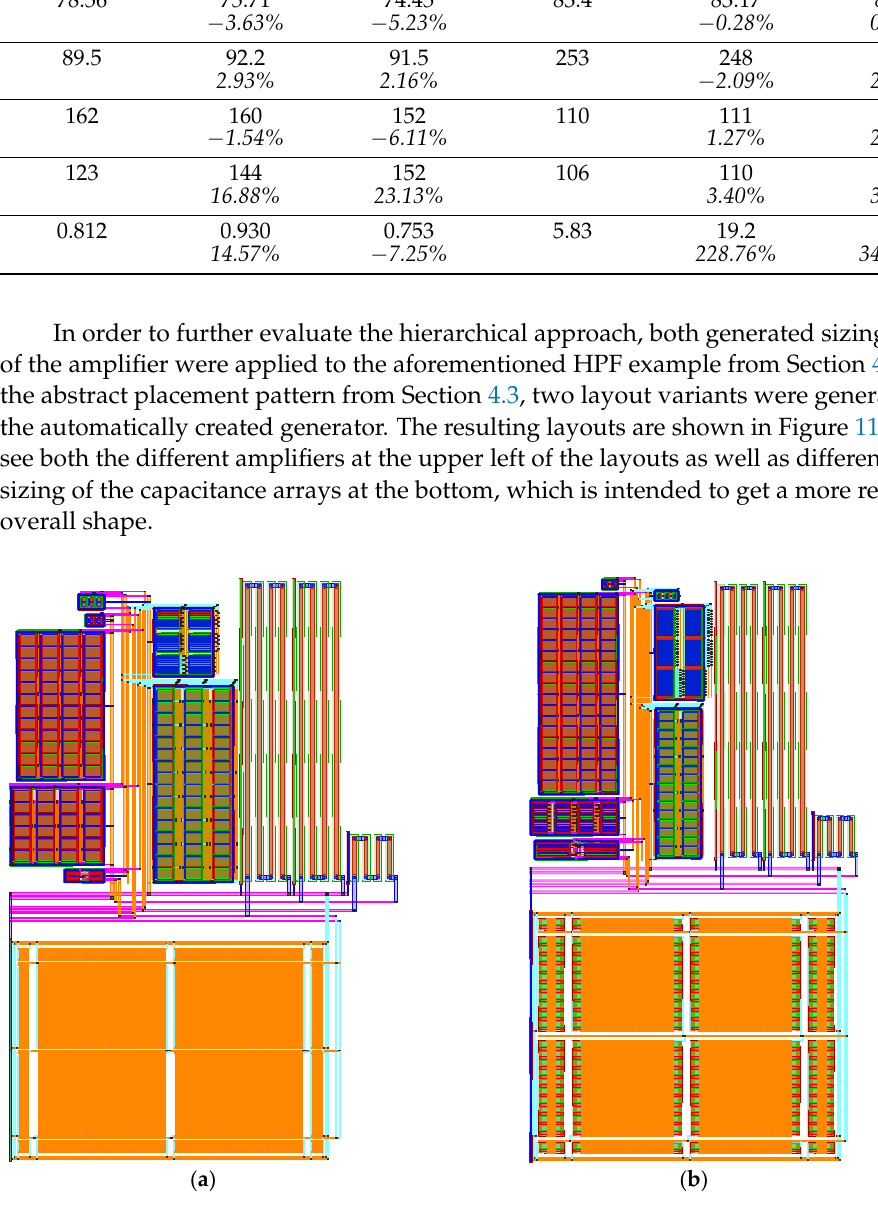
Table 1. Comparison of schematic-level and post-layout simulations of the amplifier variants.